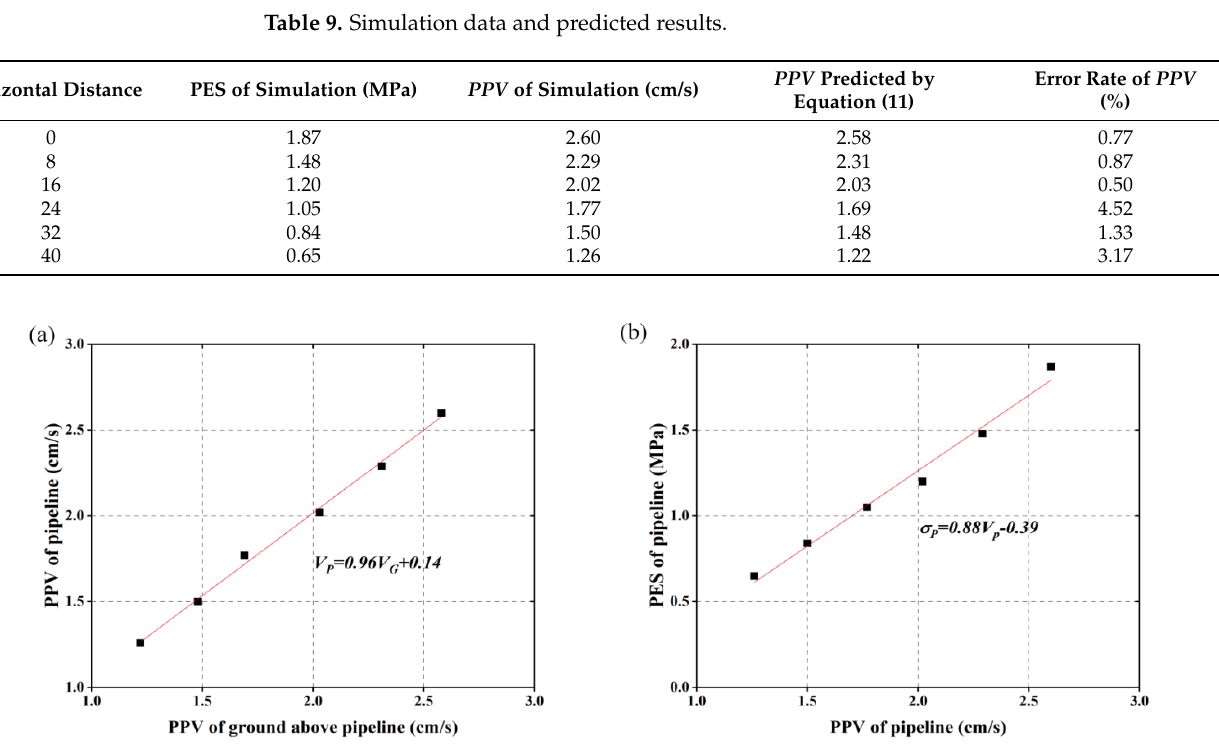
Figure 13. Statistical relationship: ( a ) PPV prediction model; ( b ) PES safety criterion.